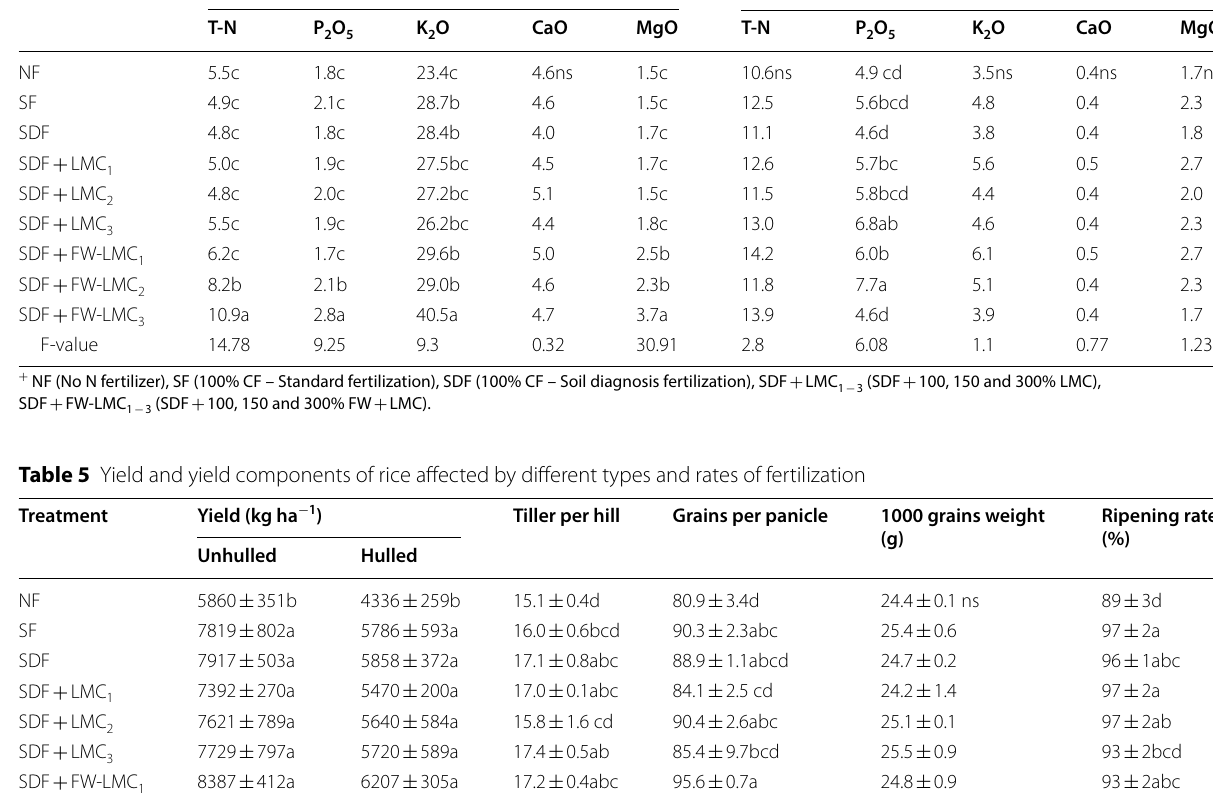
Table 4 Mineral nutrients (g kg − 1 ) in straw and grain of rice grown under different types and rates of fertilization at harvesting stage